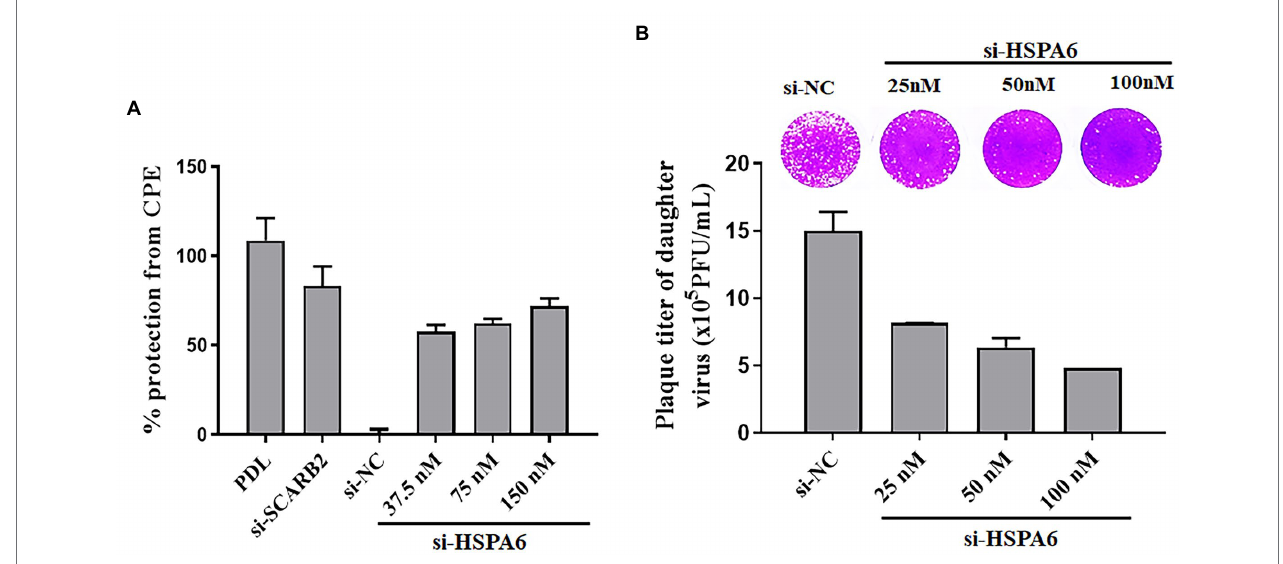
FIGURE 4 | HSPA6 knockdown inhibits EV71 CPE formation and daughter virus production. (A) siRNA targeting HSPA6 protected RD cells from EV71-induced CPE. (B) siRNA targeting HSPA6 inhibited the production of the EV71 daughter virus. RD cells were transfected with siRNAs for 24 h and then infected with 0.2 MOI EV71 for 72 h, followed by cytopathic analysis. At the same time, the culture supernatant was subjected to plaque reduction